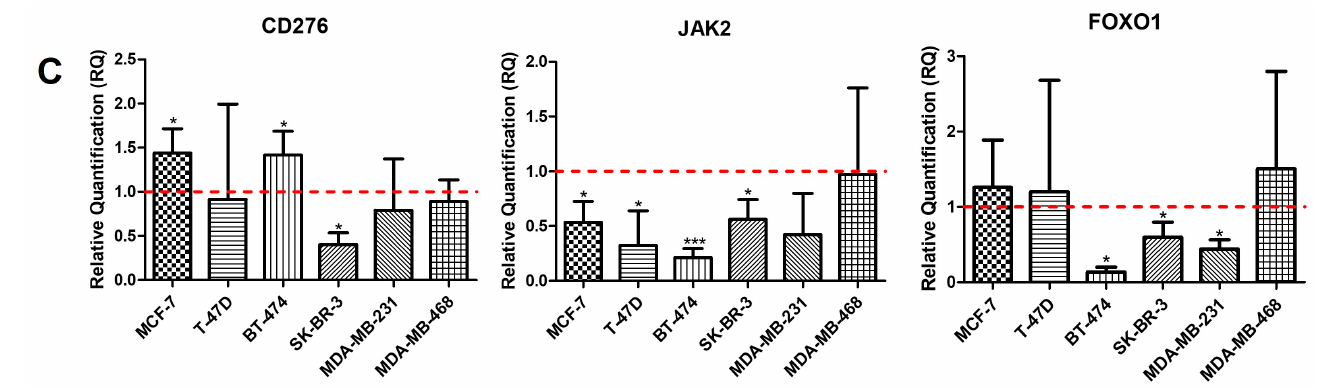
Figure 1. ( A ) Relative mRNA quantification of ( A ) CTLA-4 , PDCD1 (PD1), ( B ) CD274 (PD-L1), PDCD1LG2 (PD-L2), ( C ) CD276 (B7-H3), JAK2 , and FoXO1 genes in BC cell lines. All experiments were performed in triplicate. Each graph shows the three replicates’ mean value and standard deviation. * p < 0.05 compared to breast epithelium cell line 184A1 (red line). n.d., no data. CD274 (PD-L1) and PDCD1LG2 (PD-L2) were also increased in MDA-MB-231